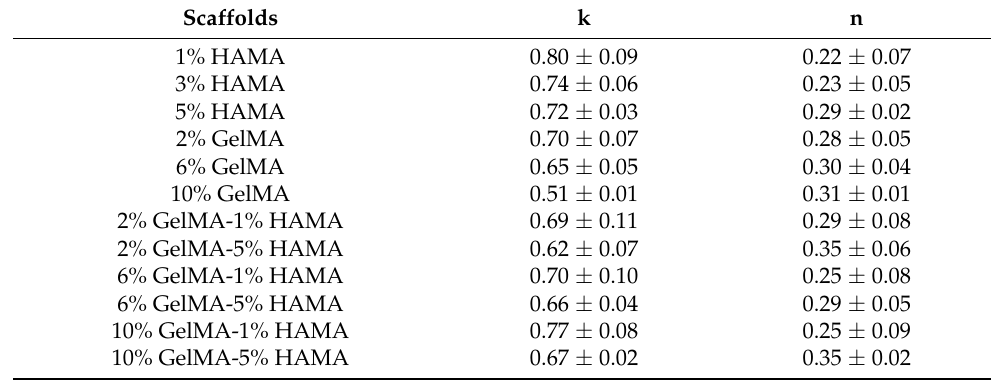
Table 2. Swelling kinetic fitting data of pure and hybrid scaffolds according to Equation (6). Scaffolds k n 1%